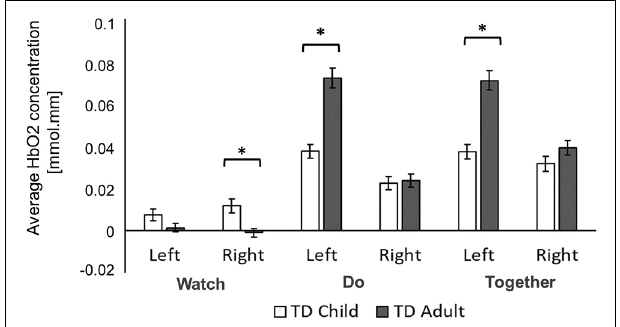
FIGURE 6 | Group differences in average HbO 2 concentration. ∗ Indicates a significant difference between